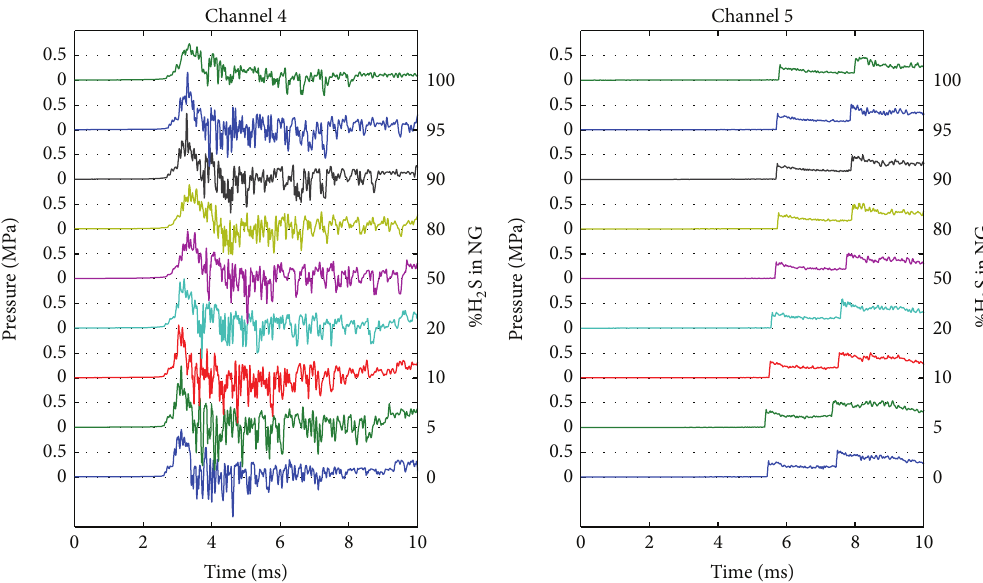
Figure 12: From bottom: tests 23, 31, 34, 35, 36, 37, 39, 40, and 28. Comparison of pressure records from channels 4 and 5. The mixture varies from pure natural gas in the fuel (bottom) to pure H 2 S in the fuel (top). All experiments are stoichiometric mixtures.